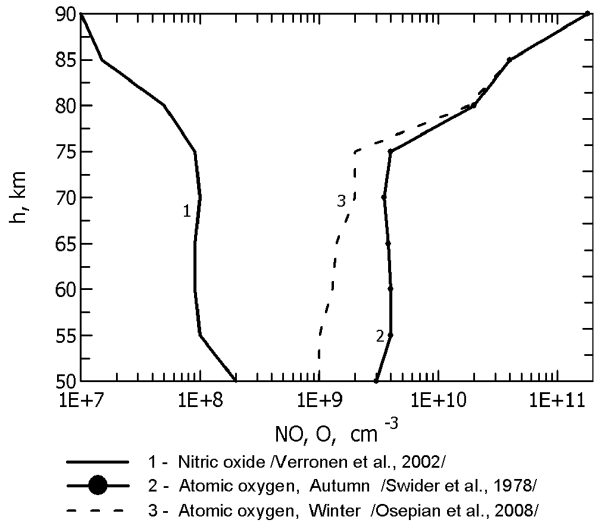
Fig. 2. Input values for nitric oxide (curve 1, Verronen et al., 2002) and atomic oxygen: curve 2 is for the autumn season (Swider et al., 1978) and curve 3 is for winter daytime (Osepian et al., 2008).